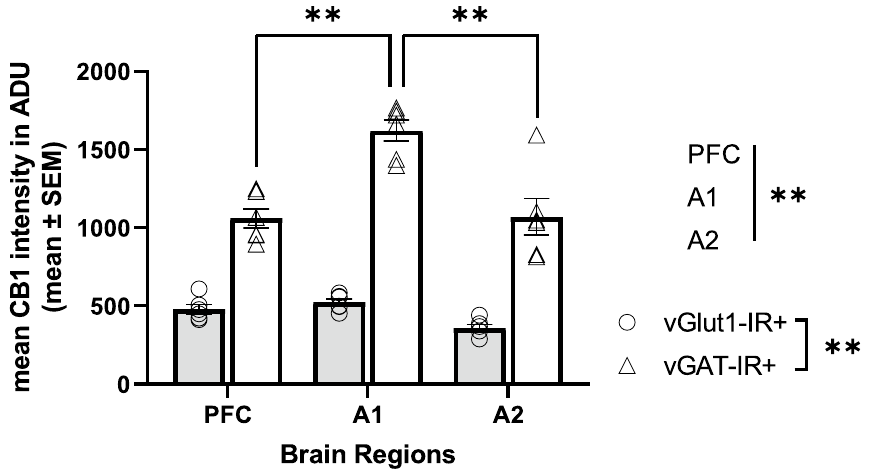
Figure 3. Mean CB1R intensity within excitatory (vGlut1-IR +) and inhibitory (vGAT-IR +) cell types across three brain regions of the monkey cortex. Each individual data point represents mean intensity averaged across all sampled sites across a cortical layer. There was a main effect of cell type, p < 0.001, main effect of brain region, p < 0.001, and a significant cell type × brain region interaction, p < 0.001. While there were no differences in mean CB1R intensity within excitatory populations across brain regions, post hoc analysis indicated mean CB1R intensity within inhibitory populations was highest in the primary auditory cortex, followed by the association auditory cortex, with lowest mean CB1R intensity within inhibitory populations in the PFC, p < 0.001. Straight lines indicate main effects across groups. Brackets indicate post hoc pairwise comparisons. ** p < 0.001. Error bar denotes SEM. PFC = prefrontal cortex, A1 = primary auditory cortex, A2 = association auditory cortex.